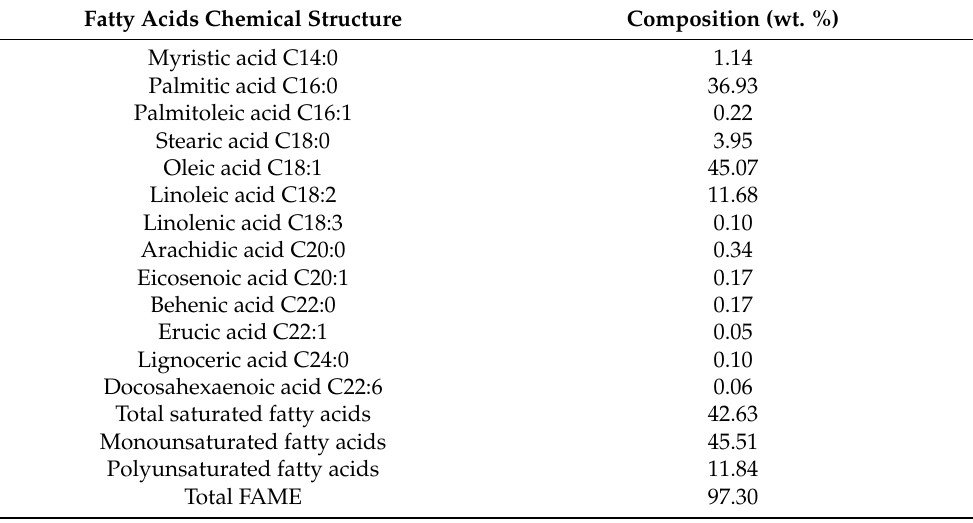
Figure 1. Variations of the water content of the biodiesel product with the initial water content in the raw palm oil. Table 1. Composition of fatty acid methyl esters (FAME) produced from palm oil with 0.05 wt. % initial water content added.